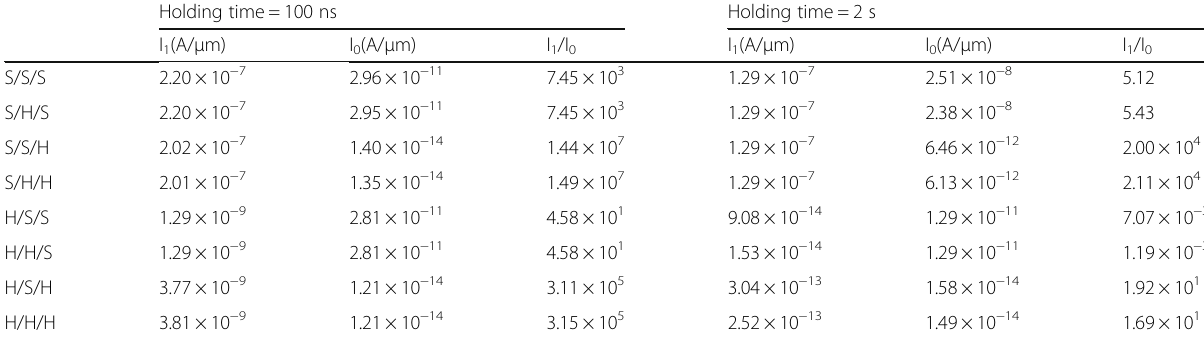
Table 2 Extracted performance properties of DGTFET DRAM with different spacer dielectrics Holding time = 100 ns